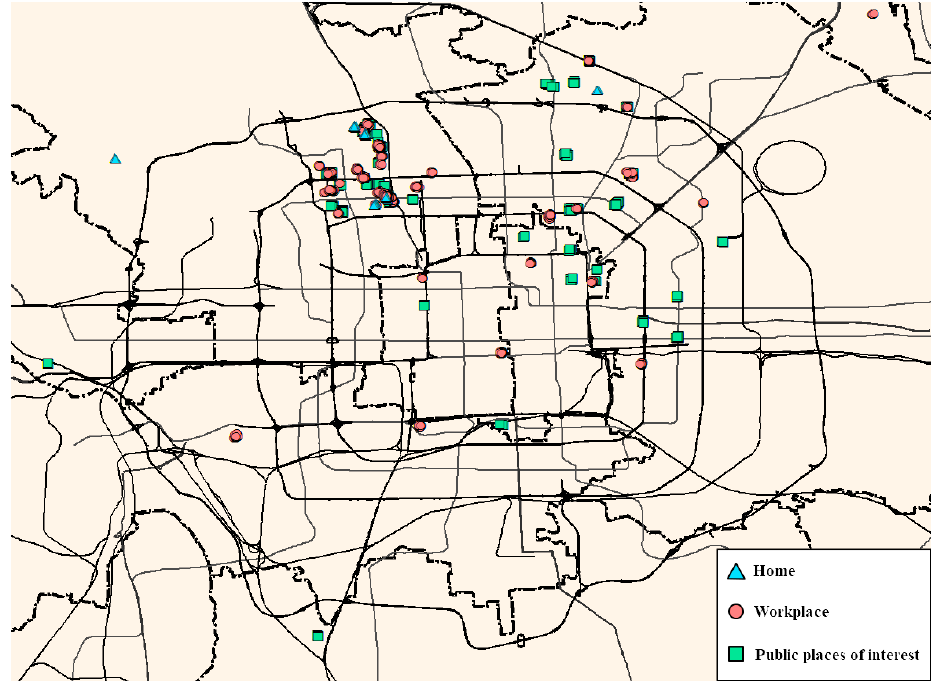
Figure 4. Semantic interpretation of significant places.